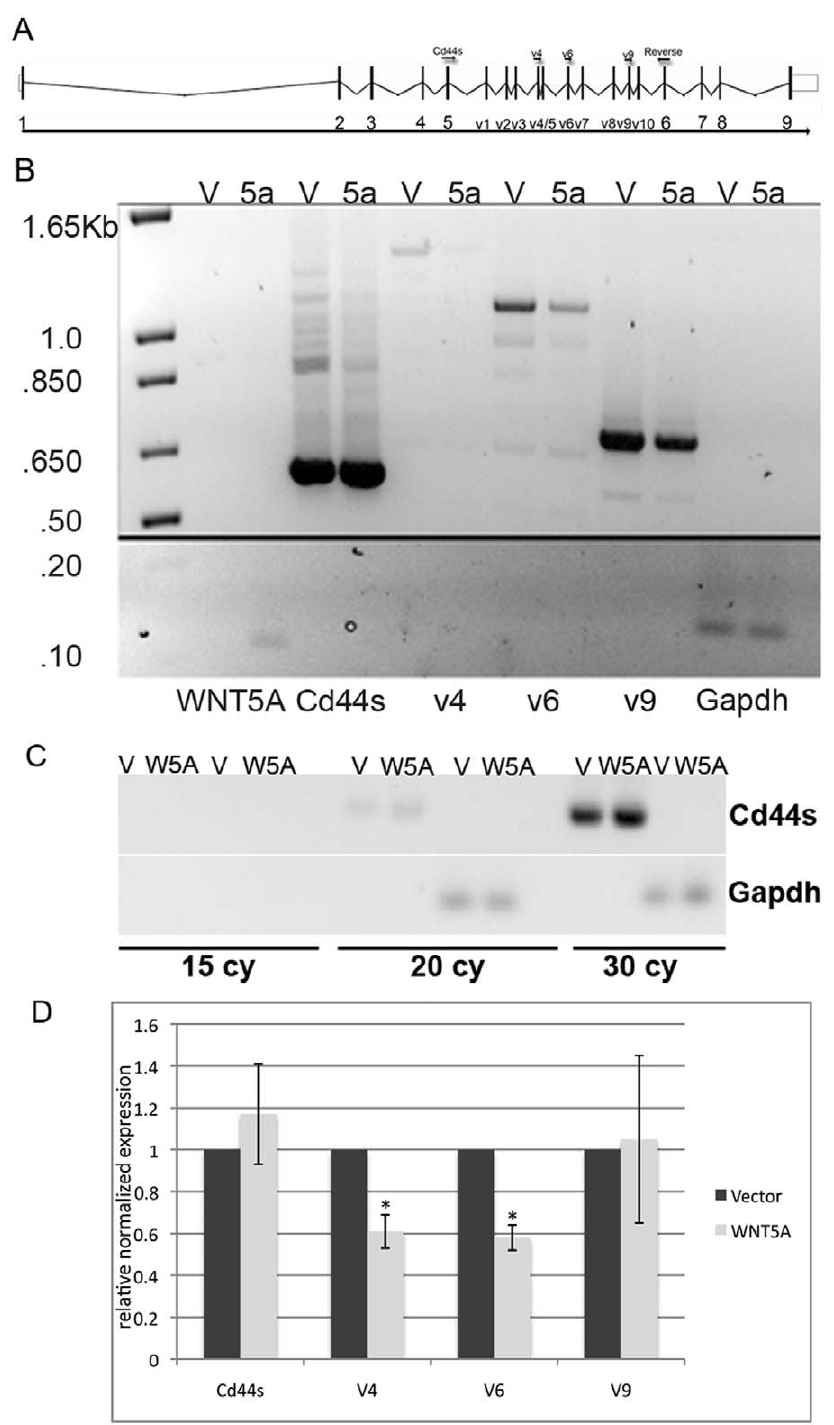
Figure 5. Alternative Cd44 exon usage. (A) Genomic structure of mouse Cd44 is shown. Cd44 has 9 non-variable exons numbered 1 to 9 (large). After non-variable exon 5 there are 10 variable exons numbered v1 to v10 (small). Primers used for RT-PCR are shown as small arrows on top of the genome structure. All PCR reactions used the same reverse primer in exon 6. Cd44s, the non-variable form of Cdd4, is the main PCR product amplified using the Cd44s primer in exon 5. Variable exons are amplified using primers in exon v4, v6 and v9. (B) RT-PCR for various Cd44 transcripts is shown (Cd44s, v4, v6, and v9). Expression of WNT5A was confirmed using primers to human WNT5A. Gapdh was used as a normalization control. (C) PCR was carried out for varying cycles to determine the linear range of product formation. Amplification of Cd44s is shown. Gapdh is used as a control for normalization. (D) Pixel density of bands from the images of the stained gels was determined and normalized to that of Gapdh. Bands in the linear range of product formation were used. Three separate experiments were analyzed. The vector was set to 1.0 and the relative levels of Cd44s, V4, V6 and V9 were determined. The average and standard deviation are shown on the graph. *=T-test p-value , 0.05.